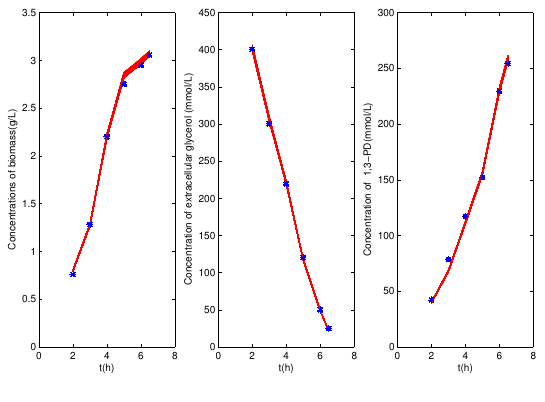
Figure 2. Comparison of biomass, glycerol, 1,3-PD concentration between experimental data and computational results x ( t,x 2